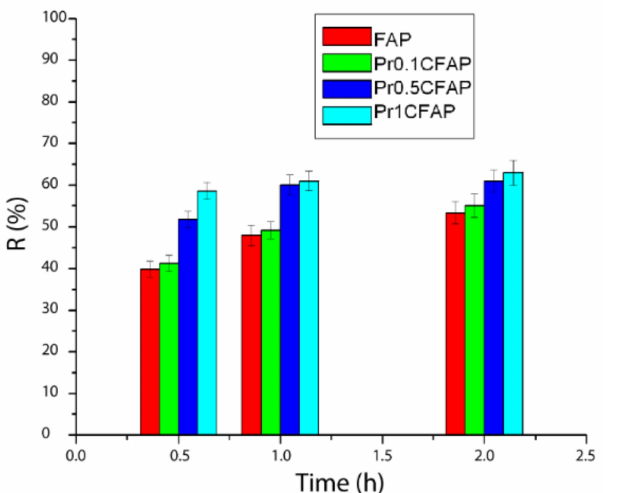
Figure 8. The percentage of bacterial reduction (R%) for E. coli after the treatment with the synthesized powders in